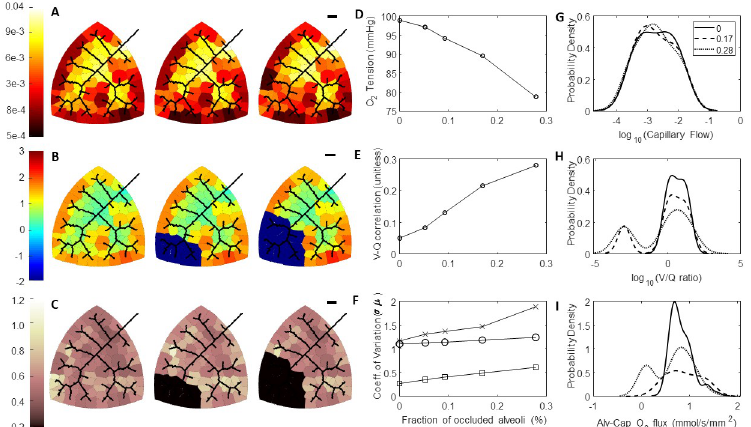
Fig 10. Effect of airway occlusions on HPV-mediated redistributions in hemodynamics, V/Q matching, and oxygen flux. (A-C) Leftmost column of networks are with 0% of the alveoli occluded, middle column of networks are with 17% of the alveoli occluded, and the rightmost column of networks are with 28% of the alveoli occluded. The first airway occlusion is at the most southwestern perfusion zone, and progressive airway occlusions are made following the structure of the vascular network. The black scale bar is 1000 μ m. (A) Perfusion in the capillary compartment; (B) Ventilation-Perfusion (V/Q) ratios in the capillary compartment; (C) Oxygen flux in the capillary compartments; (D) End-venous oxygen tension as a function of the fraction of occluded alveoli; (E); Pearson correlation between ventilation and perfusion as a function of the fraction of occluded alveoli; (F) Coefficient of Variation for blood flow (circles), V/Q ratios (x’s), and oxygen flux (squares); (G) Distribution of blood flow; (H) Distribution of V/Q ratios; (G) Distribution of oxygen flux.